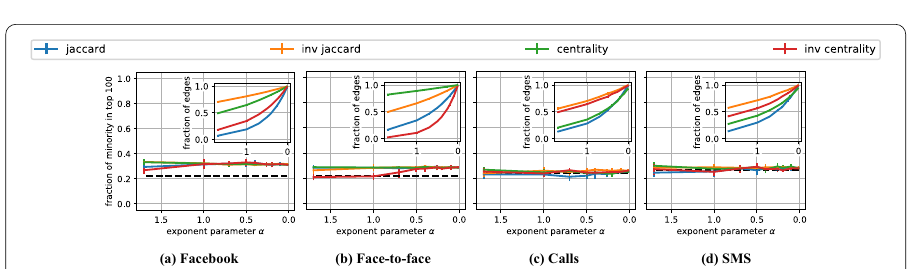
Fig. 9 Effect of node attribute-based noise on Copenhagen dataset. Similar to Fig. 3 we plot the influence of the retain parameter ρ on the different communication channels of the Copenhagen Network dataset. The effects of the different noise types are present in all communication channels and are in line with simulations on larger networks in section “Experiments on real-world networks”